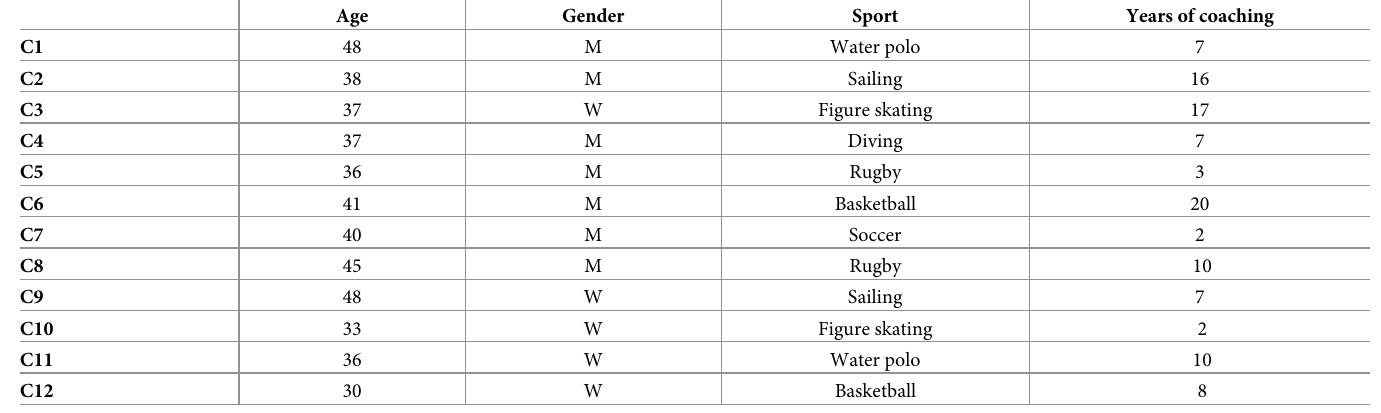
Table 1. Overview of the participants.